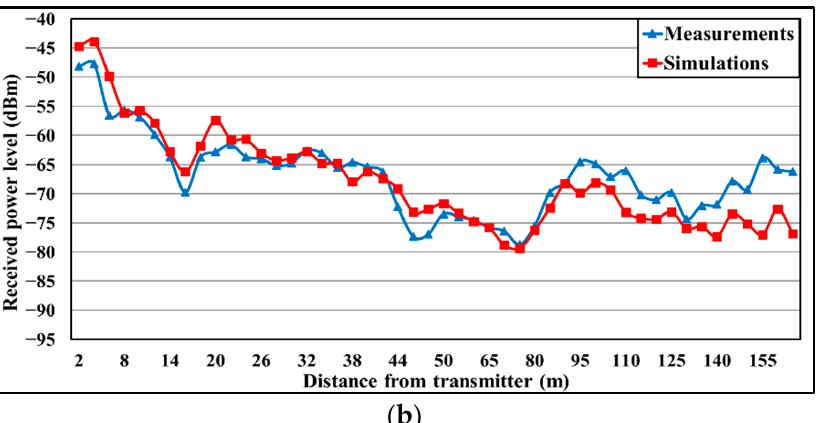
Figure 8. Comparison between RF measurements and simulations using the 3D-RL tool for the frequency bands of: ( a ) 975 MHz; ( b ) 2.4 GHz.